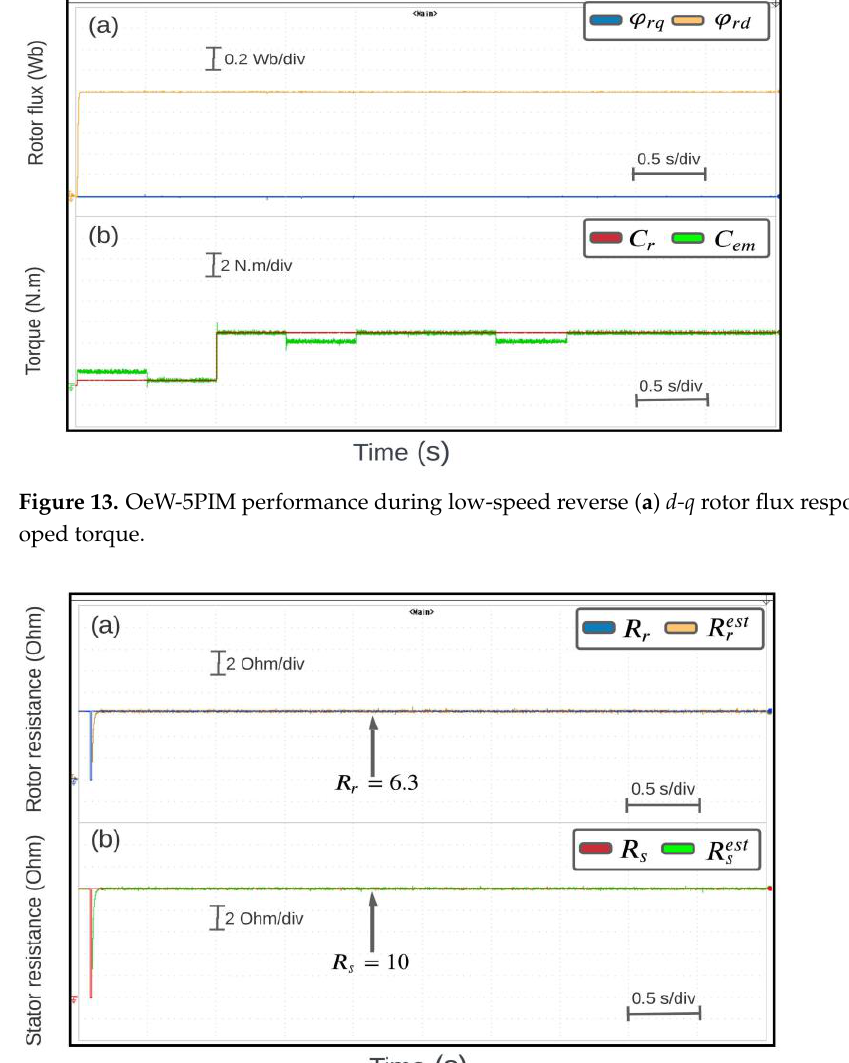
Figure 12. OeW-5PIM performance during low-speed reverse ( a ) speeds responses; ( b ) estimation error.